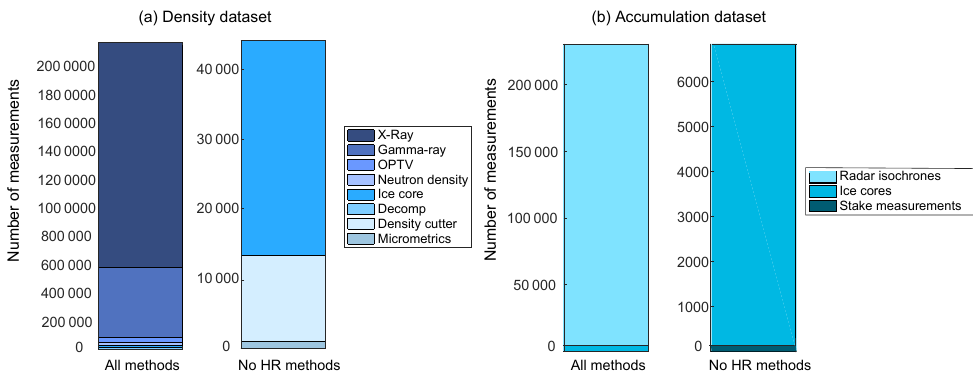
Figure 2. Bar charts showing the measurement methods in the (a) density subdataset and (b) accumulation subdataset. The left bar in each plot shows the distribution of all methods and the right bar shows the distribution of methods excluding the high-resolution spatial (accumulation) or depth (density) measurements.